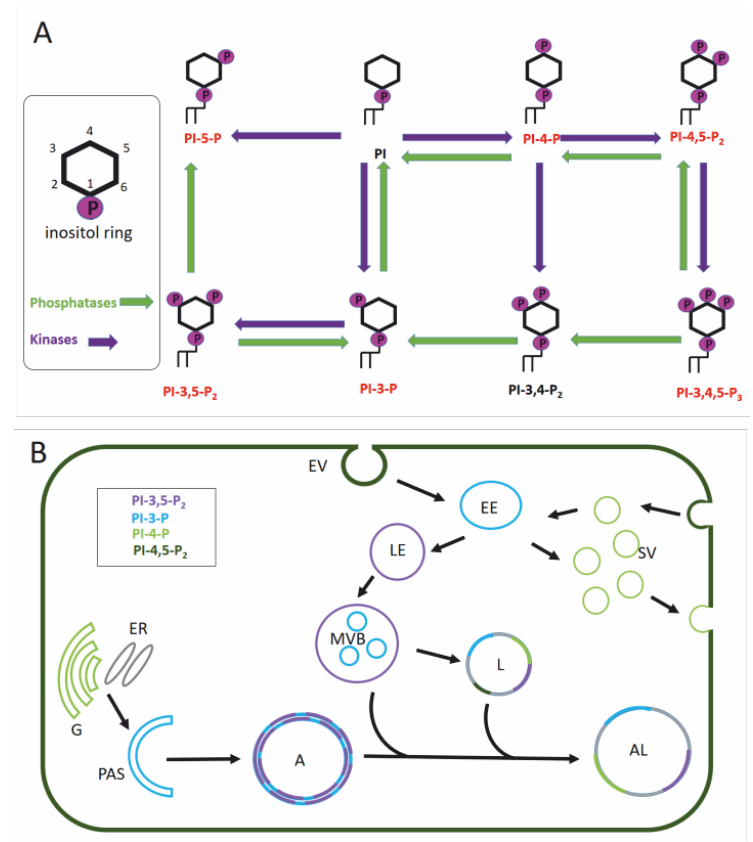
( Figure 2A ). The presence and composition of phospho- inositides in the membrane creates the membrane identity of the organelle ( Figure 2B ) and offers specific protein binding sites for signalling events [51, 52].